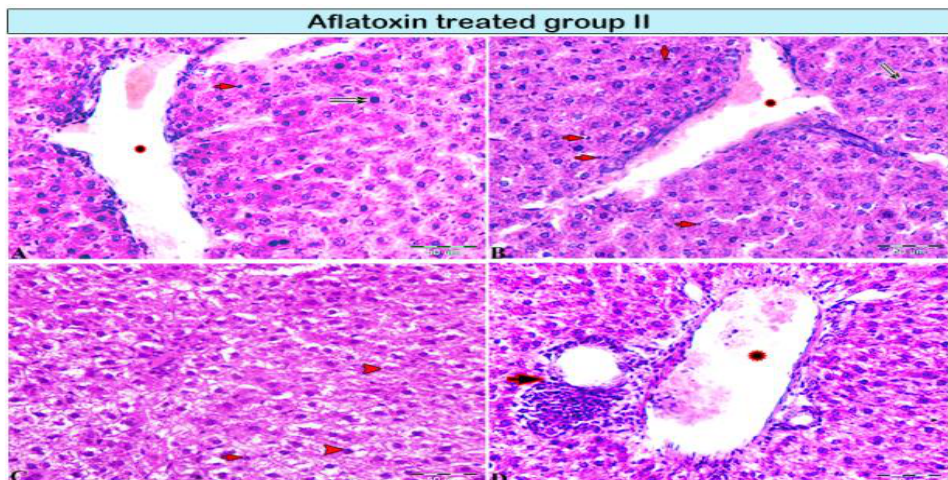
Figure 2. Photomicrograph of a rat liver in aflatoxin B1-treated group II (4-week treatment). ( A, B ) Central vein dilation (star), mononuclear cell infiltration (red arrows), cellular necrosis (pyknotic nucleus; double black arrow), incomplete mitotic division (A: black arrow). ( C ) Vacuolar degeneration of hepatocytes (red arrowheads). ( D ) Interlobular vein extensively dilated and congested with blood (star), periportal interlobular bile duct fibrosis with focal mononuclear cellular infiltration (arrow).